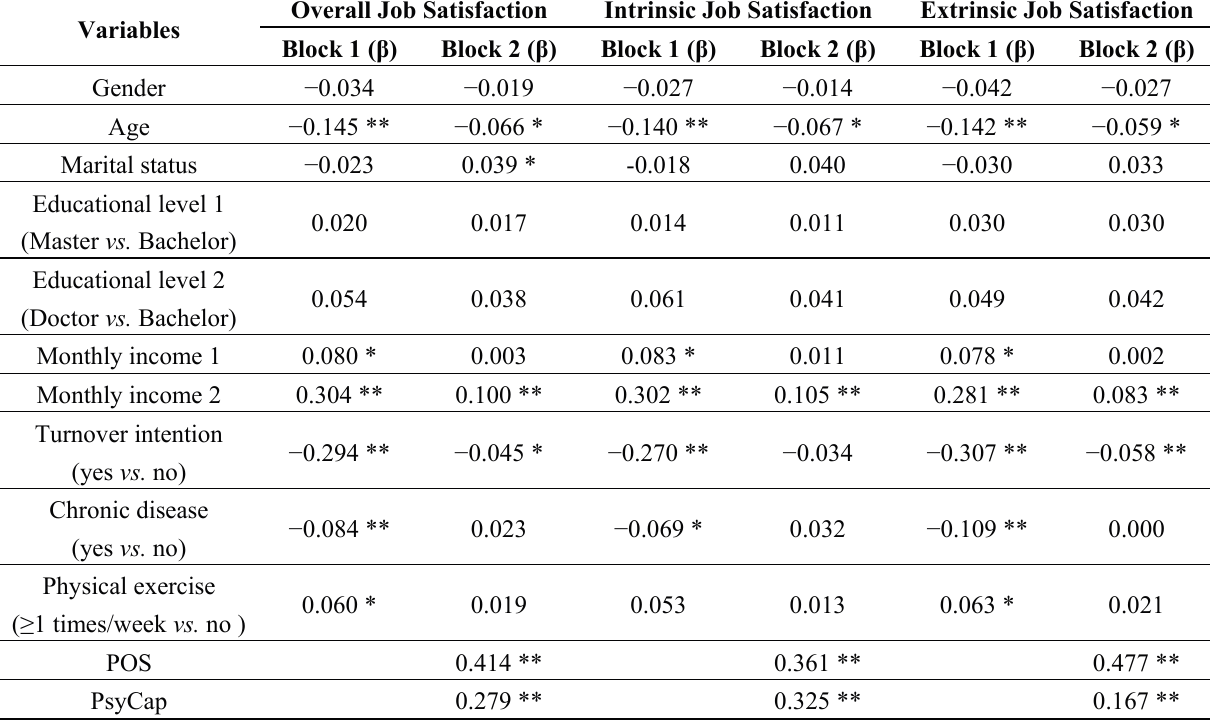
Table 3. Hierarchical linear regression analyses for exploring associated factors for job satisfaction